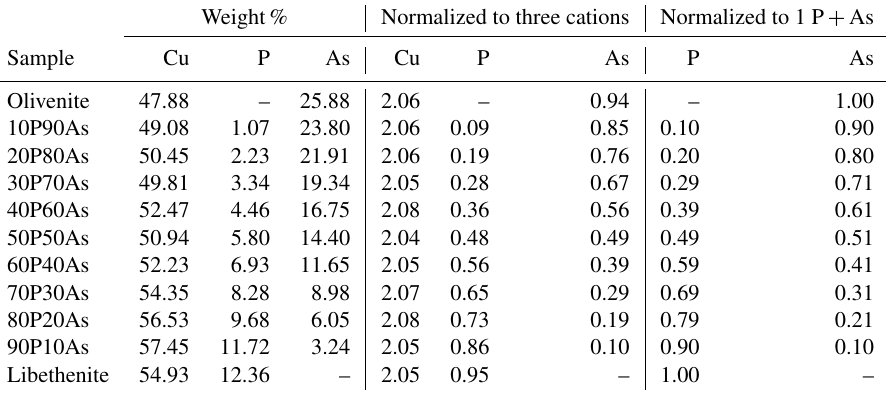
Libethenite 54.93